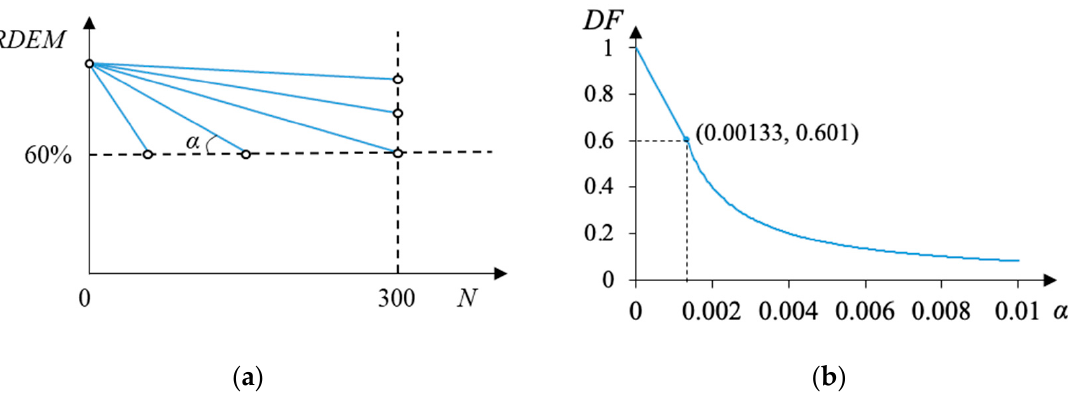
Figure 24. The mathematic relation between the durability factor ( DF ) and linear deterioration speed– α , ( a ) Definition of DF and corresponding α ; ( b ) continuous relation between DF and α .